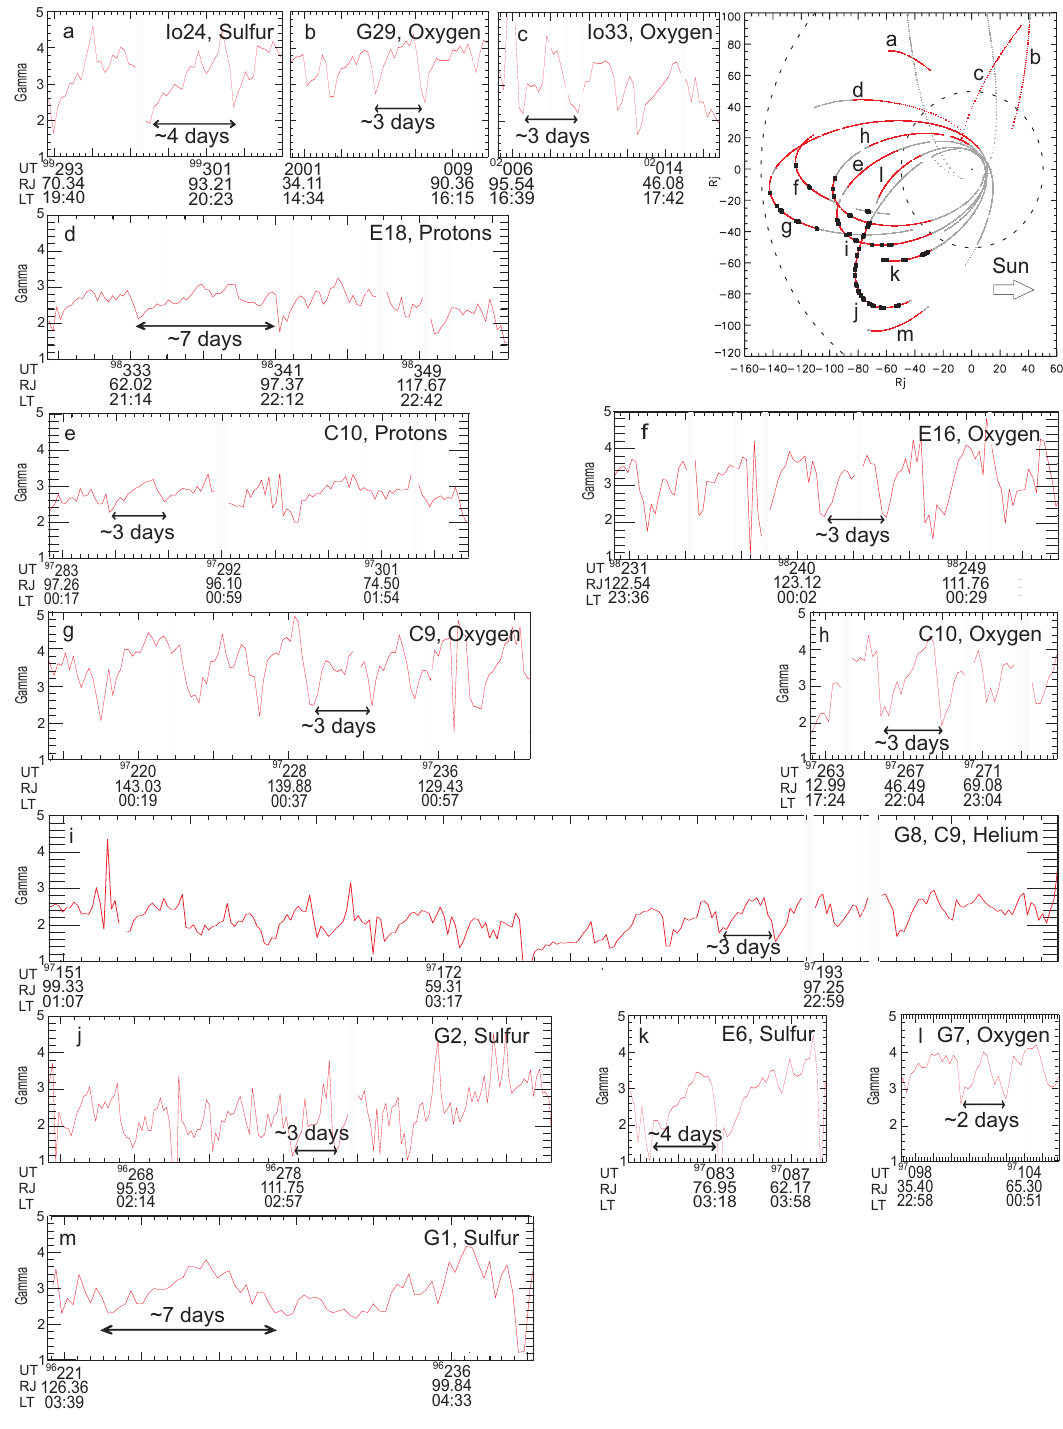
Fig. 1. The G2–Io33 orbits of Galileo in Jupiter Solar Ecliptic coordinates excluding time periods with insufficient data coverage (upper right panel). Along red coloured orbits Galileo observed a periodic behavior of the ion spectral index γ . The spectral index for protons is calculated using two energy channels (80–220keV/nuc and 220–540keV/nuc); for helium (27–155keV/nuc and 155–1000keV/nuc); for oxygen (26– 51keV/nuc and 51–112keV/nuc); for sulfur (16–30keV/nuc and 30–62keV/nuc). The locations of the flow bursts, or reconfiguration events (as identified in Woch et al. (1999); Kronberg et al. (2005)) are marked by black dots. These flow bursts are also present in Figs. 2–5, as deviations from the corotational flow. Each time series is denoted by a letter which shows the location of the corresponding orbit (see upper right